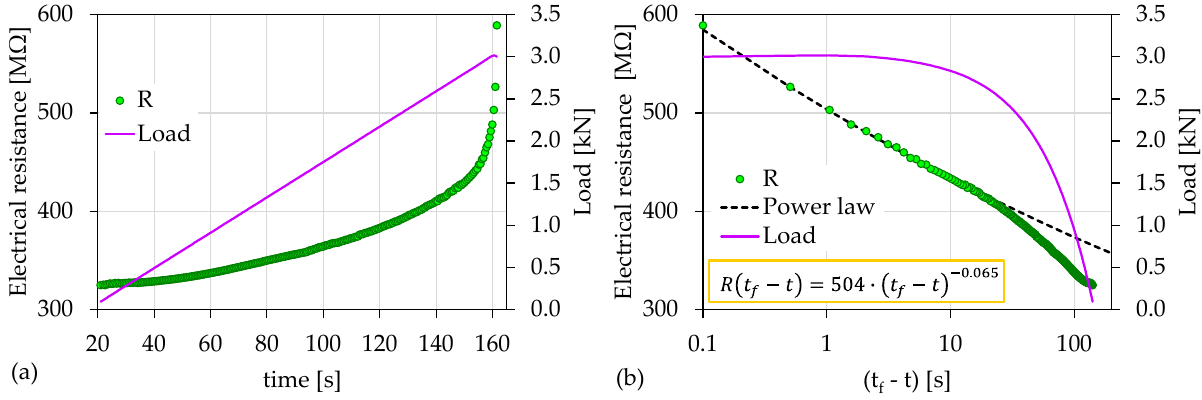
Figure 2. ( a ) The temporal evolution of the electrical resistance ( R ) in juxtaposition to the load applied for the experiment Exp-LR1; ( b ) the respective temporal evolution of the recorded electrical resistance ( R ) in terms of the “time-to-failure” parameter.